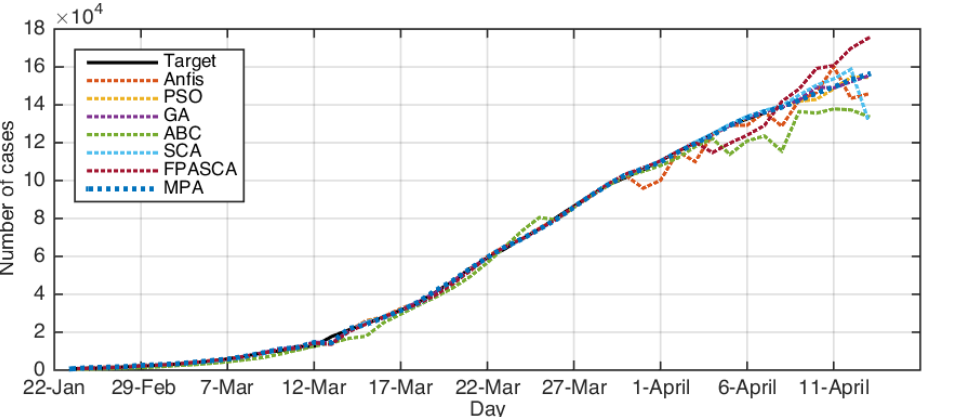
Figure 6. The results for Italy using ABC, ANFIS, FPASSA, GA, MPA, SCA, and PSO against real data